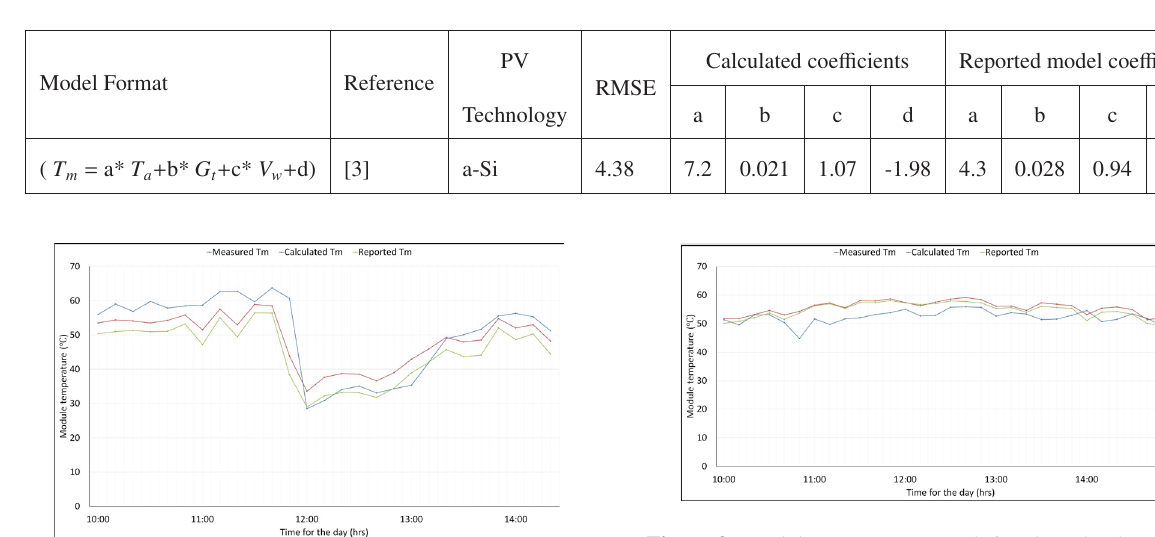
Figure 1. Outdoor test set up of a-Si / thin film PV technology module at NISE, Gurgaon, India [2]. Table 1: Calculated coe ffi cients and their RMSE, along with coe ffi cients of reported model [3].